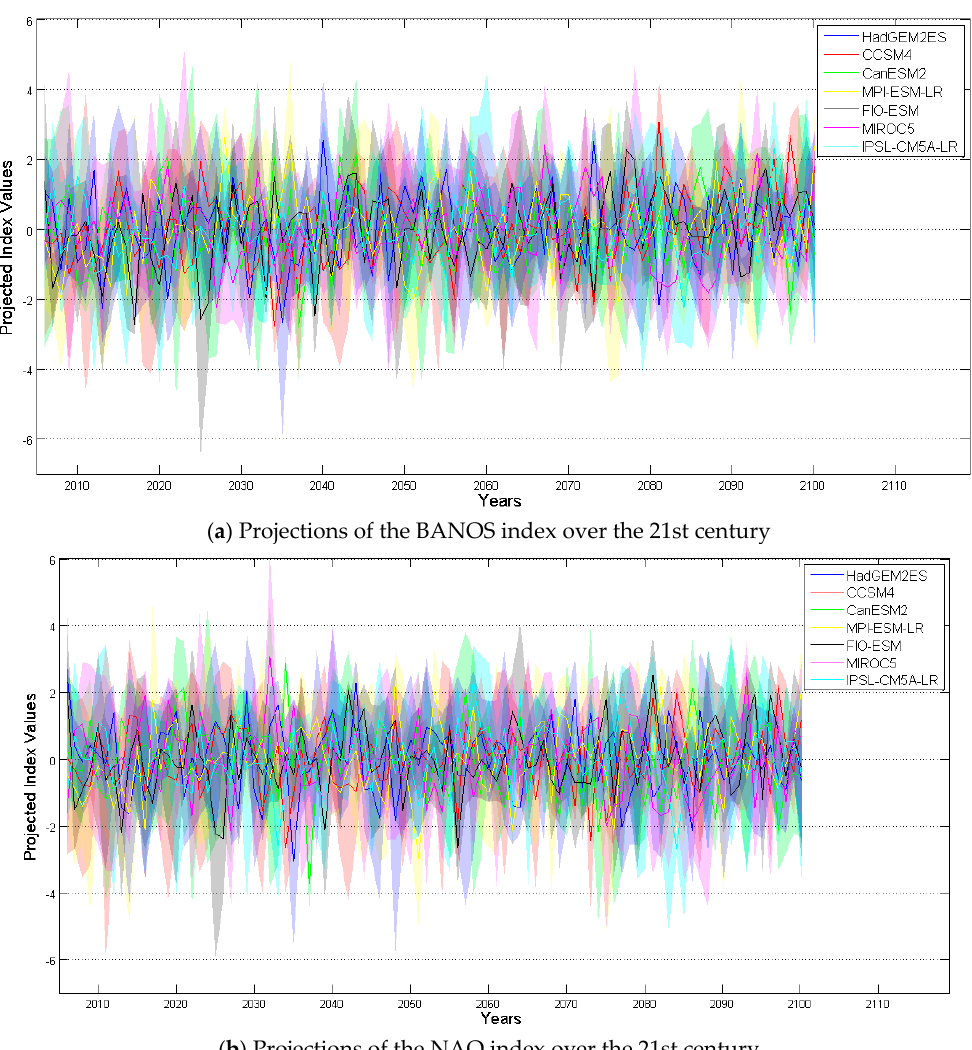
Figure 3. Projections of the atmospheric indices (BANOS and NAO) variations. The CMIP5 models on the top panel show the BANOS index projections, the CMIP5 models on the bottom panel show the NAO index projections. The models are ranked from top (best) to bottom (worst) with respect to their performances. The lines represent ensemble means and the shaded areas show individual ensemble spreads.